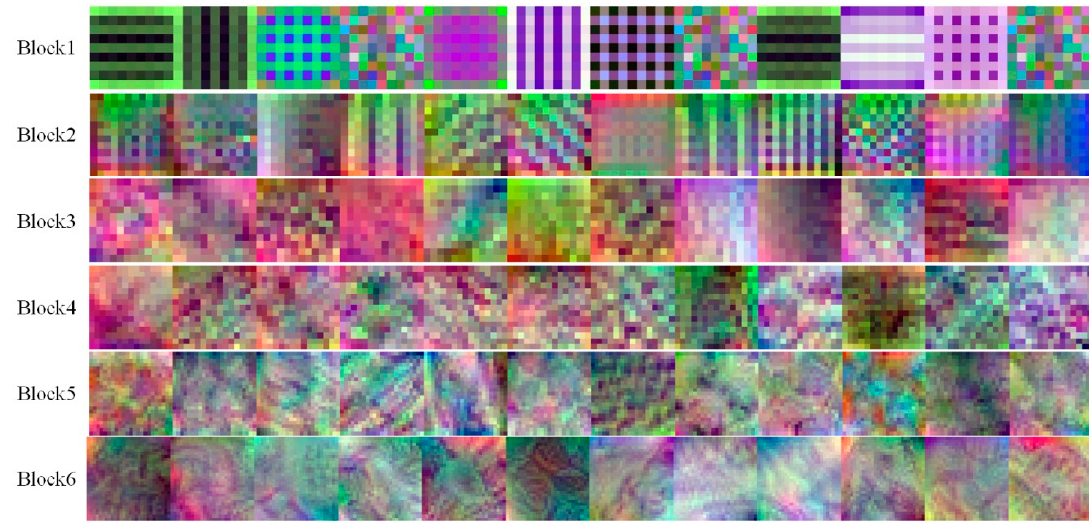
Figure 14. Visualization of some filters of the last convolutional layer of each block of the IRM- YOLOv2 structure.